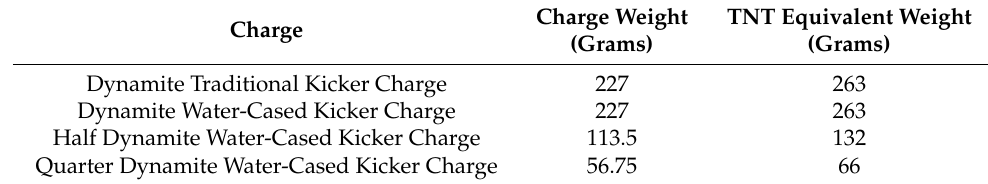
Table 1. Equivalent weights of explosives.